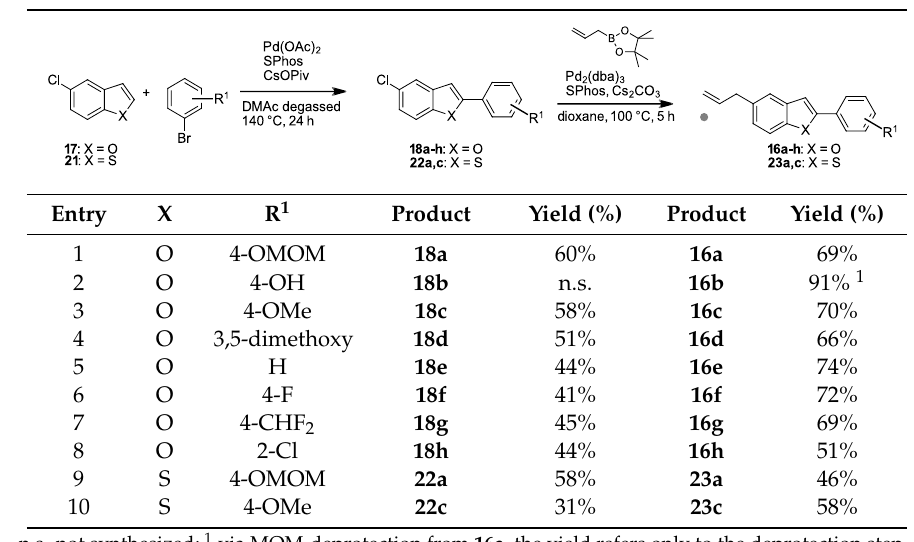
Table 1. Direct arylation and subsequent allylation.